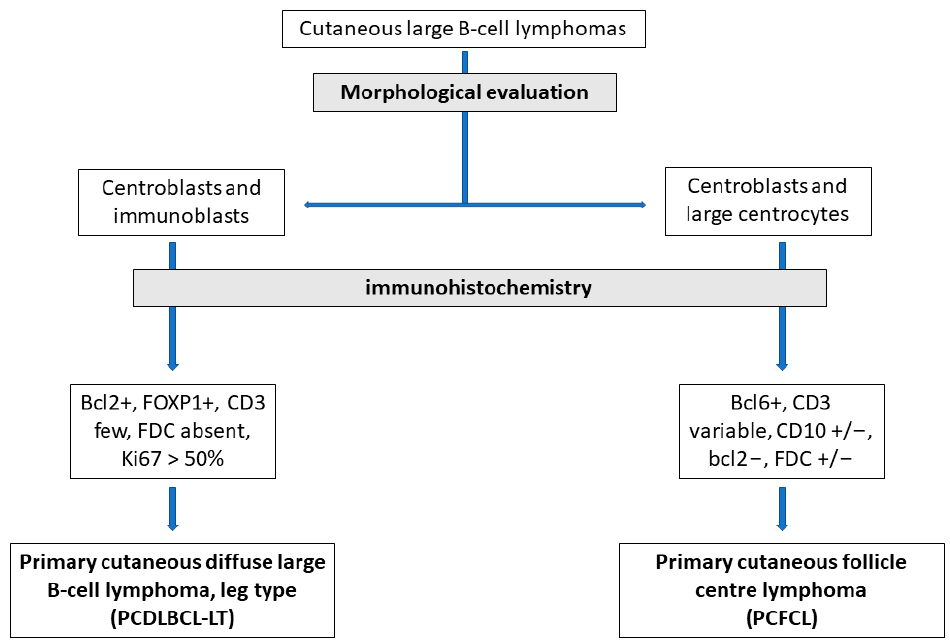
Figure 6. Diagnostic algorithm for the di ff erential diagnosis between PCDLBCL-LT and PCFCL.